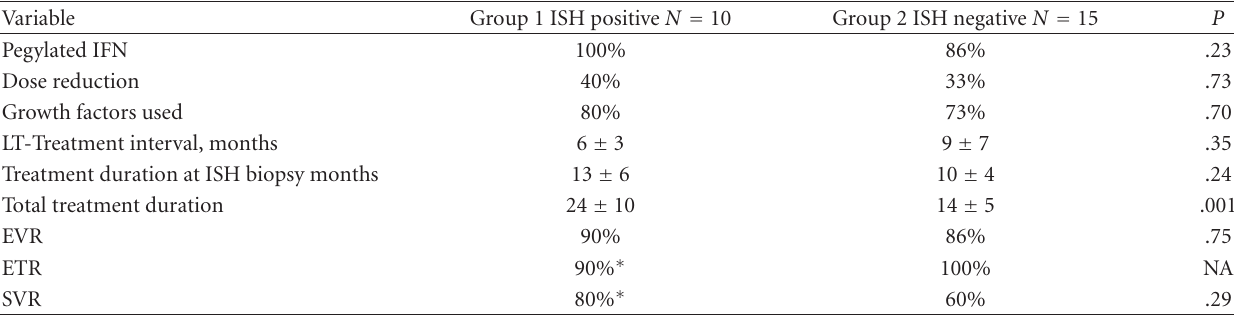
Table 2: Antiviral therapy timing, duration, dose reductions, growth factor use, and virologic outcomes in treated group 1 and 2 patients.